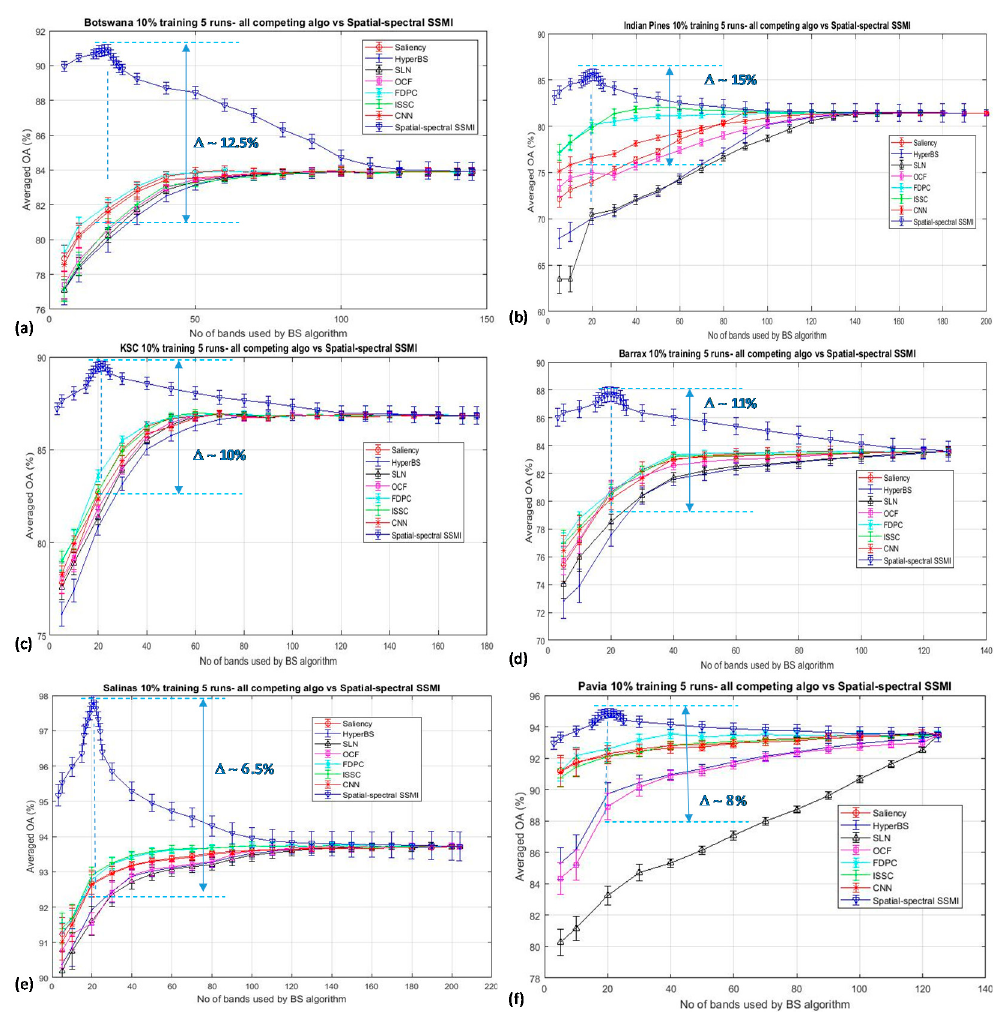
Figure 7. The classification performances of the proposed SSMI and seven other competing algorithms for the classification of 6 datasets ( a ) Botswana, ( b ) Indian Pines, ( c ) KSC, ( d ) Barrax, ( e ) Salinas, and ( f ) Pavia University. In all cases, the training data sizes were kept at 10% per class and every data point involves 5 repeated experimental runs. The averaged enhancement of the classification by the proposed SSMI with respect to the mean of the 7 competing algorithms over 6 datasets at the selected bands of 20 is approximately 10.5%.